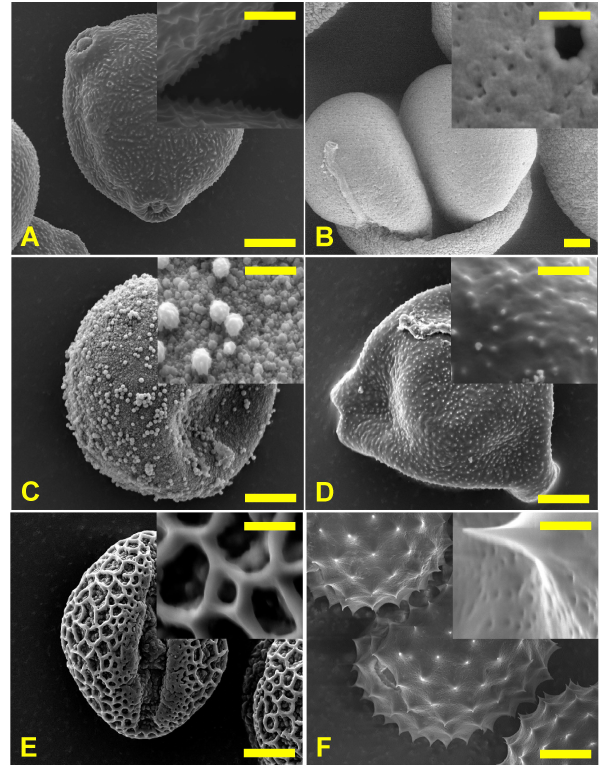
Fig. 4. SEM images of birch (A) , pine (B) , juniper I (C) , hazel (D) , willow (E) and ragweed (F) . The bar length is 5µm in the large and 1µm in the small